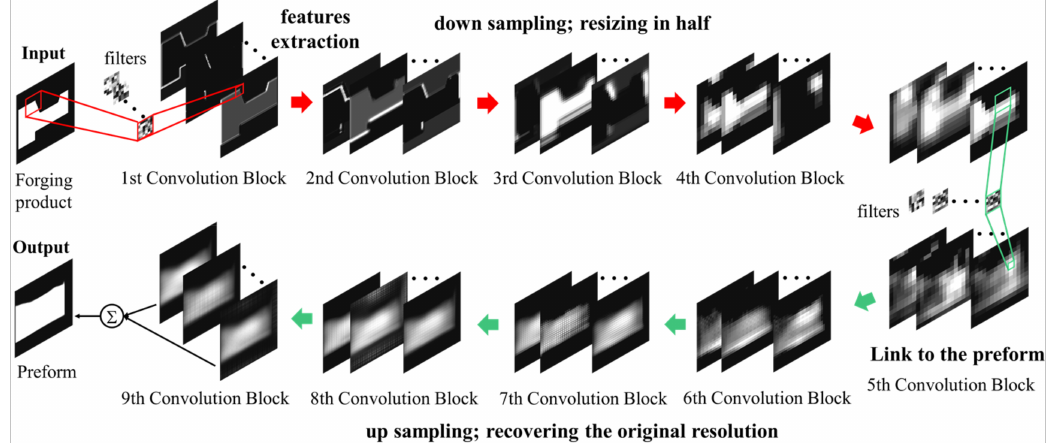
Figure 4. The preform design step during the implementation of the CNN algorithm